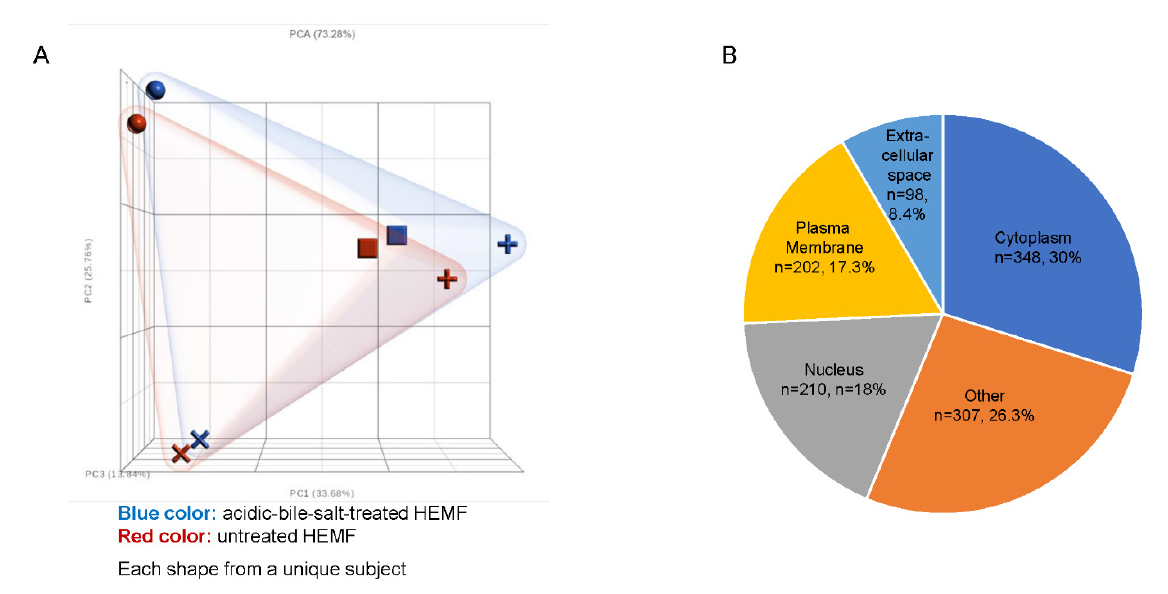
Figure 1. RNA sequencing of HEMFs. ( A ) Principal component analysis (PCA) plot of untreated (red) and treated (blue) primary HEMFs. Each shape (circle, square, cross, and plus sign) represents HEMFs isolated from a different human esophagus, with variability between samples shown by principal component percentage (PC%). ( B ) Location of differentially expressed genes.